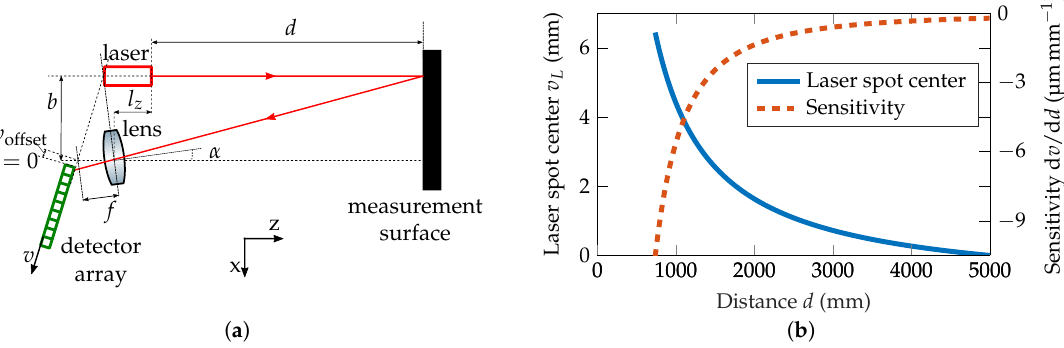
Figure 1. ( a ) Schematic of a laser triangulation setup consisting of a laser, a lens and a detector array in Scheimpflug condition. ( b ) Relation between the laser spot center v L and the distance d according to Equation (1). Sensitivity of the setup, defined by the shift of the laser spot center over the corresponding distance change. The detector is shifted in v -direction such that a maximum measurement distance of approximately 5000mm is achieved ( v offset ≈